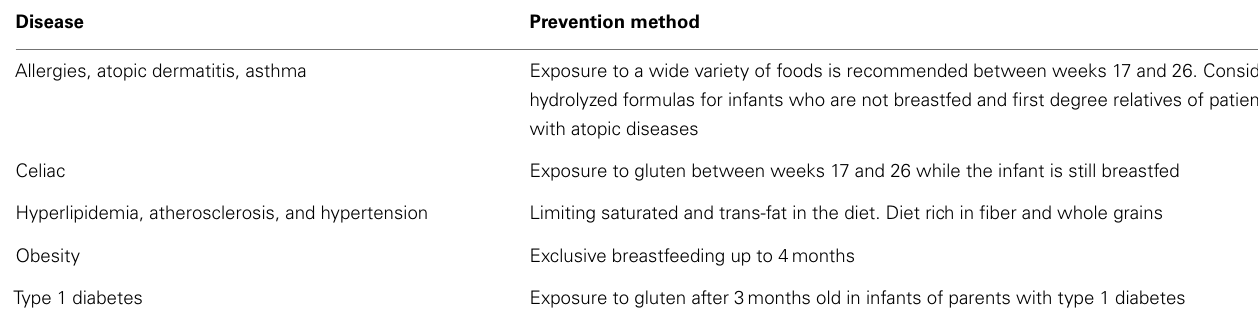
Table 1 | Diseases which may be preventable by optimal nutrition during early childhood